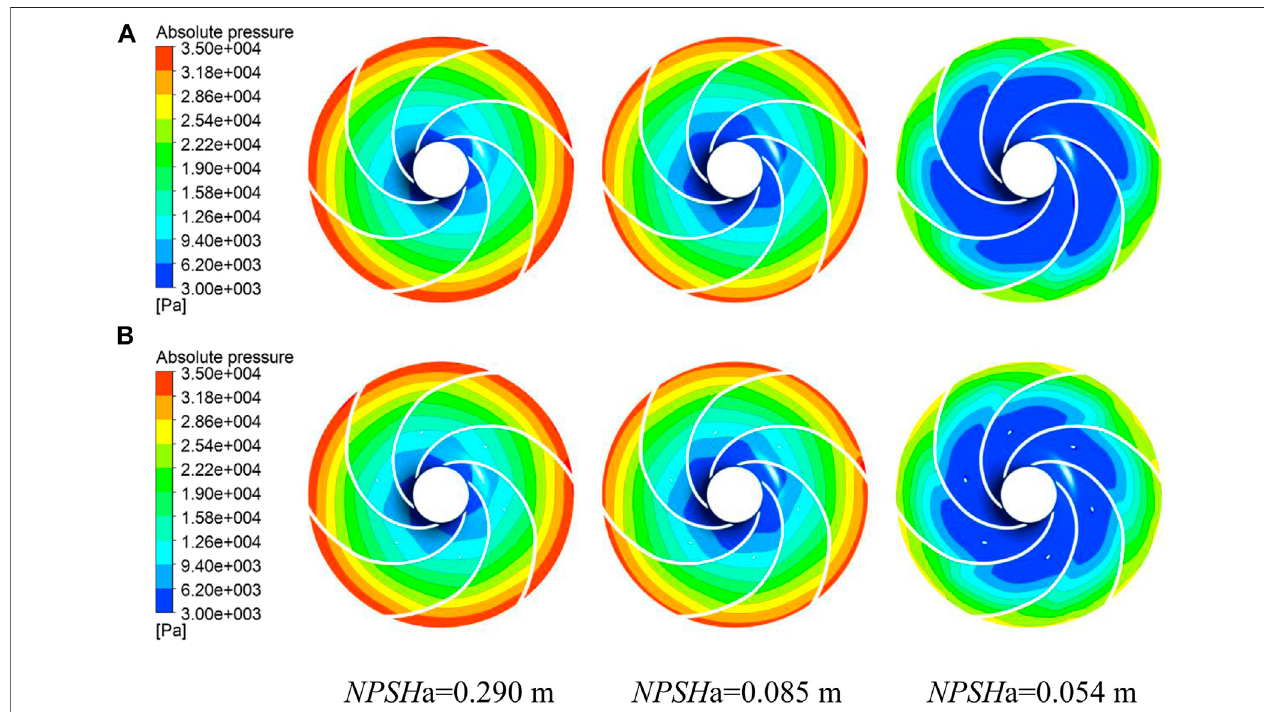
FIGURE 13 | Pressure distribution in the middle section of the impeller: (A) original impeller and (B) B3 impeller.